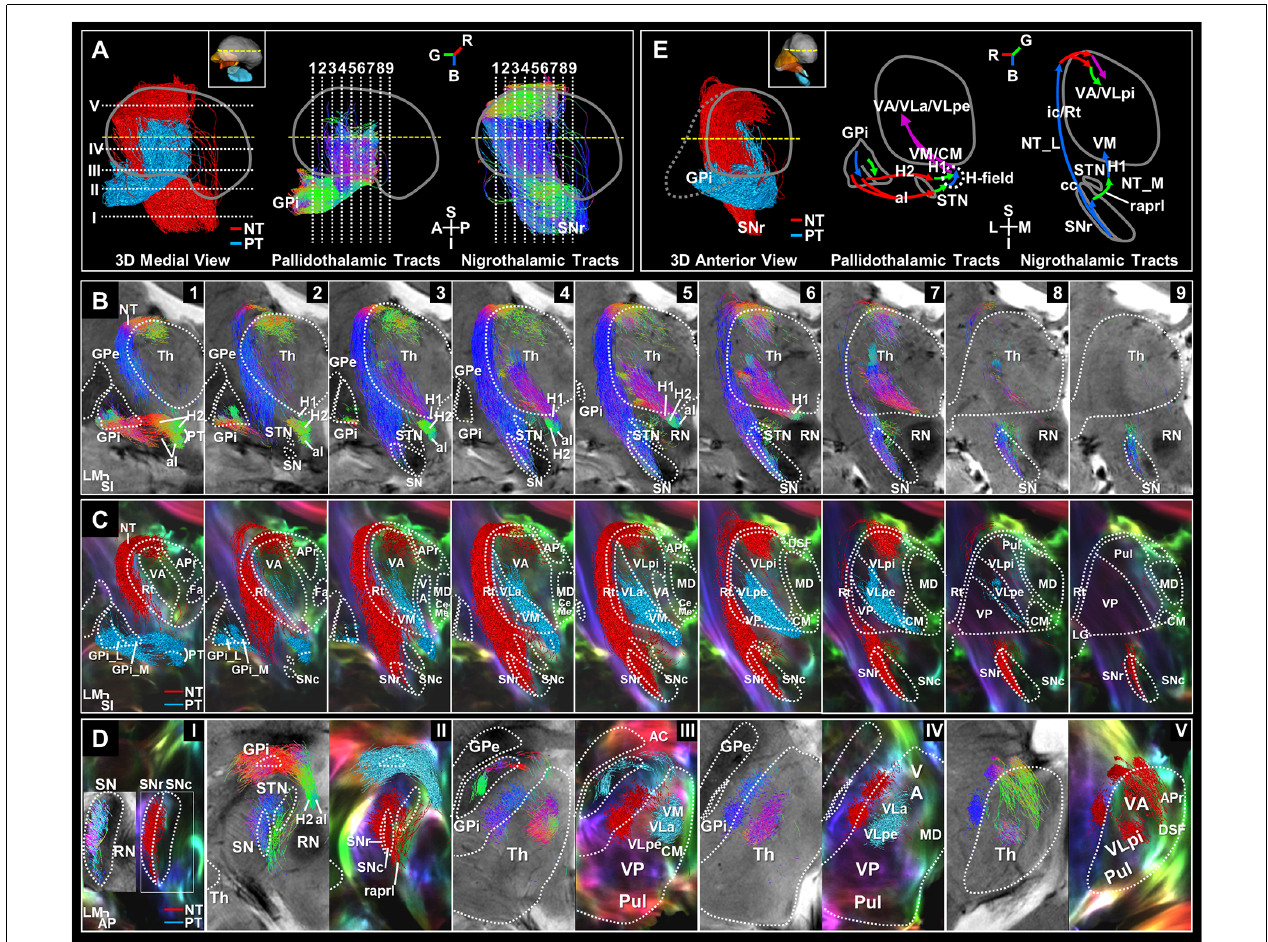
FIGURE 3 | Separation of the basal ganglia output pathways. (A) 3D color-labeled and directional color-represented streamline tracks in midsagittal view. Slice levels are shown in 3D streamlines of the pallidothalamic (PT) and nigrothalamic (NT) pathways corresponding to the slice numbers atop (B) and (D) . Directional color represents track directionality [R, red (ML), G, green (AP), B, blue (SI)]. (B) 7T T2*-weighted images overlaid with the directional color-encoded tracks of the PT and NT pathways in serial coronal views with 2 mm spacing from anterior to posterior, aligned to the slice levels in Figure 2 . (C) Super-resolution DEC-TDI maps overlaid with the 2 mm thick reconstructed color-labeled pathways (PT: red label; NT: light blue label). (D) Streamline tracks showing directionality (left column) and category (right column) were reconstructed to 1 mm thickness and superimposed in each axial view of the T2* and DEC-TDI images. (E) 3D color-labeled streamline tracks in anterior view (left). Overall, coronal schematic diagrams of the PT (center) and NT (right) pathways are shown. The path-directionality information is incorporated as an RGB color representation. Anatomical annotations and orientation abbreviation are the same as described in Figure 2 captions. AC, anterior commissure; H, H-field; H1, fasciculus thalamicus; H2, fasciculus lenticularis; NT_L, NT lateral pathway; NT_M, NT medial